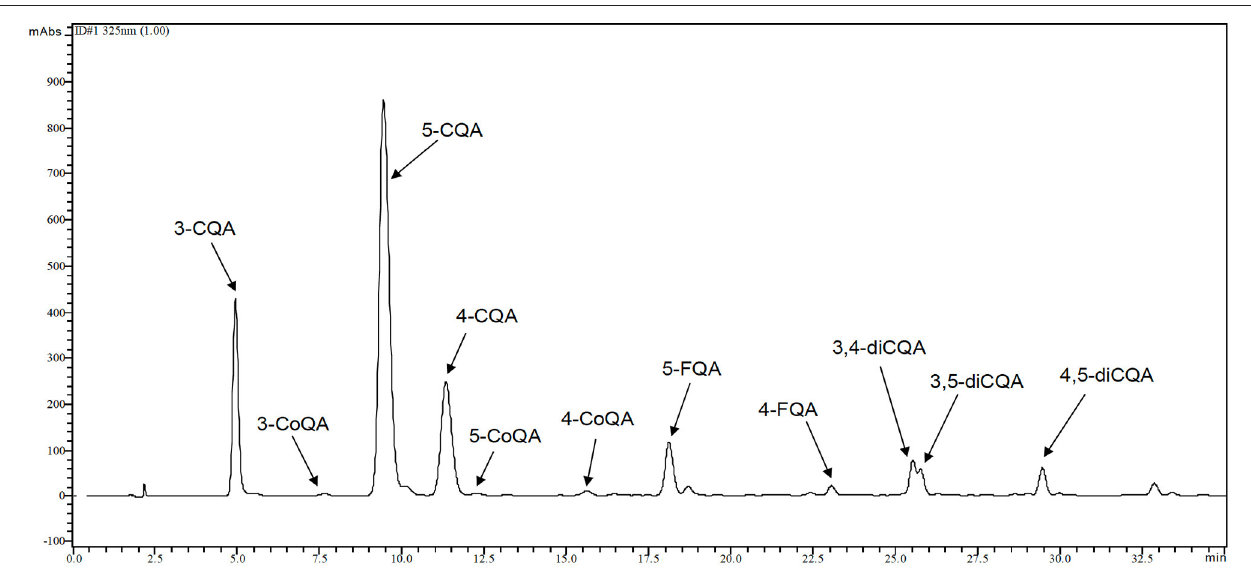
FIGURE 3 | Typical chromatographic separation of chlorogenic acids (CGA) released from non-Jacu, Jacu and Kopi Luwak coffee samples. CQA, Caffeoylquinic acid; FQA, feruloylquinic acid; diCQA, dicaffeoylquinic acid; p -CoQA, coumaroylquinic acid.